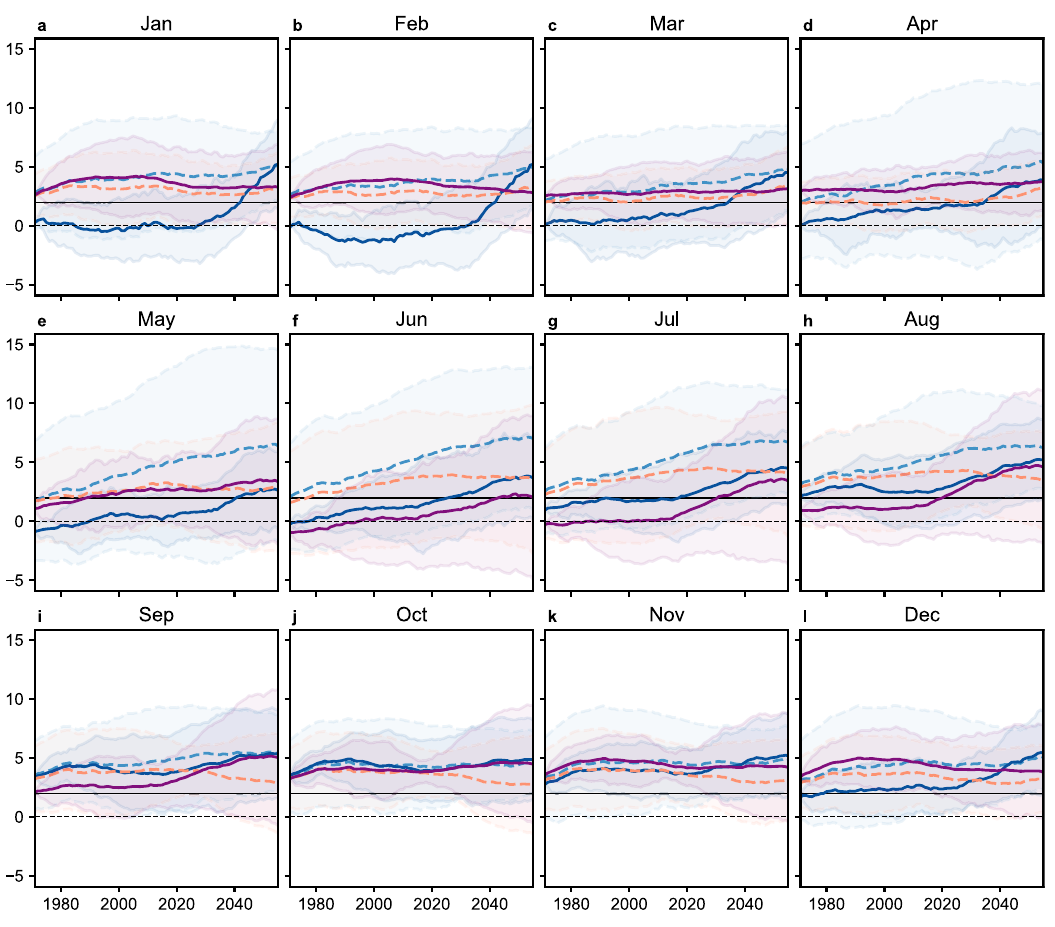
Fig. 4 | Evolution of the raw and constrained signal-to-noise (S/N) ratios over thefutureperiods1971 – 2016,1972 – 2017, … ,2055 – 2100.a – l Thex-axisindicates thestartingyearsofthefutureperiods.Darkblue (purple)solidlinesrepresentthe constrained S/N ratios of 0 – 10cm (0 – 100cm). Shaded area bound by dark blue (purple) solid lines represent the two-sided 95% con fi dence intervals of the con- strainedS/Nratiosof0 – 10cm(0 – 100cm),whichwerecalculated using regression results, not the Gaussian assumption. Light blue (orange) dashed lines represent the average of the raw S/N ratios of 0 – 10cm (0 – 100cm). Shaded area bound by